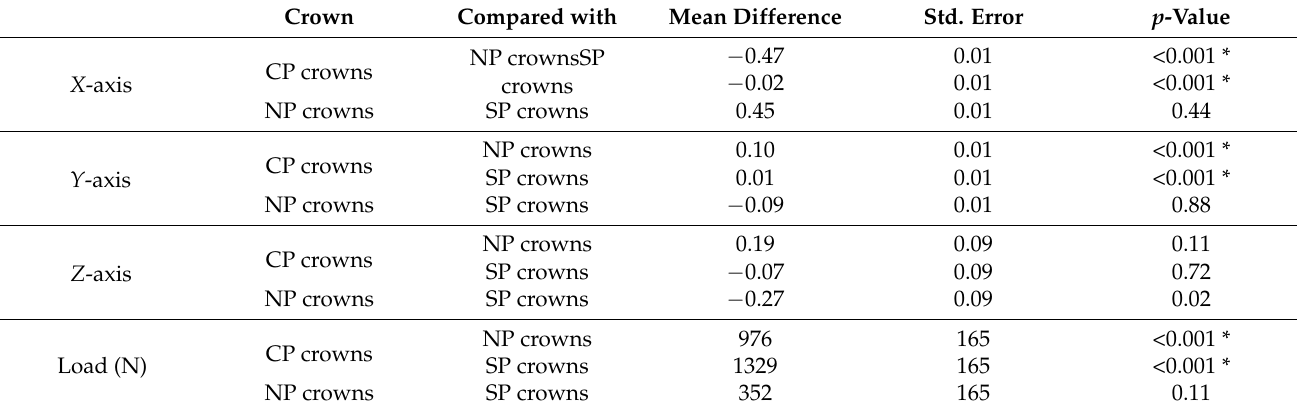
Table 3. Post hoc test with p -values among posterior crowns at different axes. Crown Compared